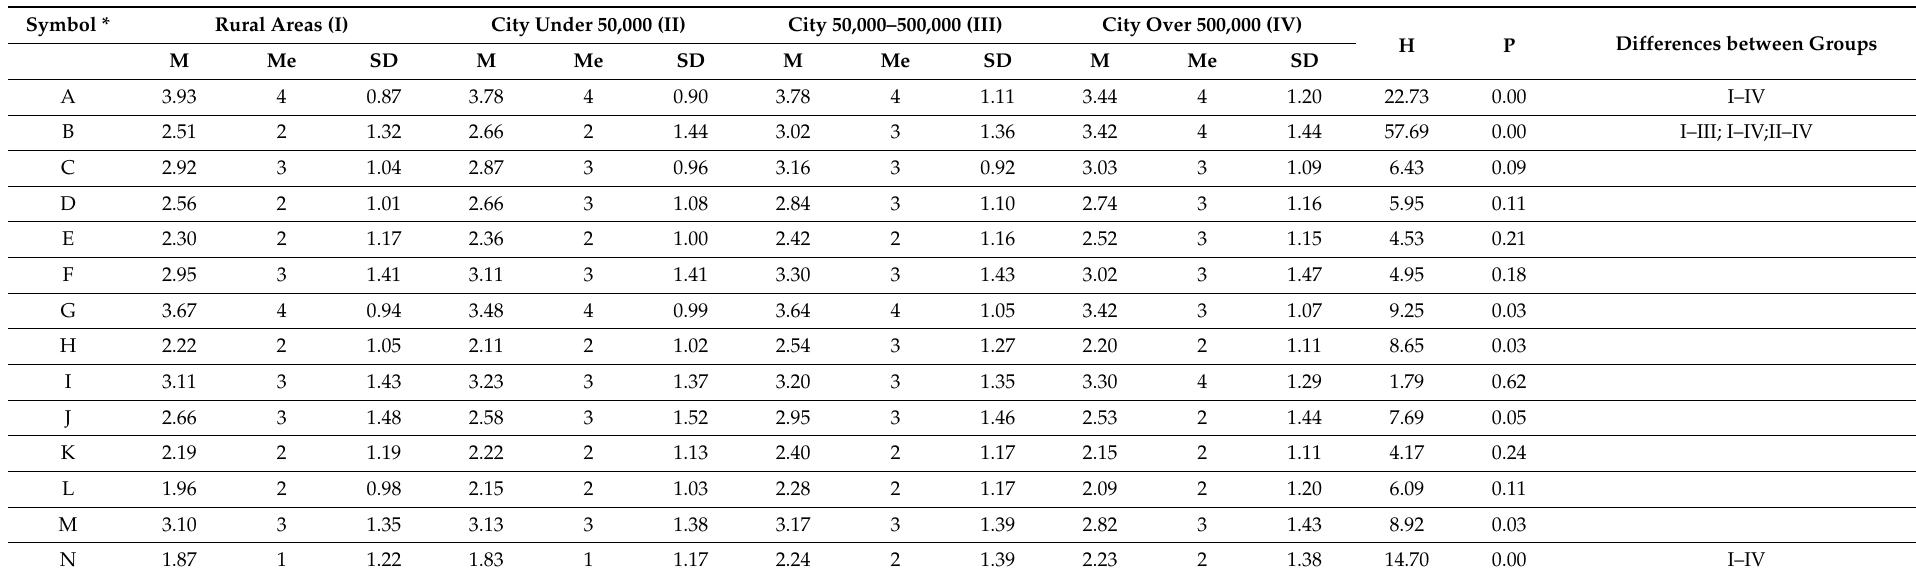
Table 4. Differences in the declaration of pro-environmental behaviors by the place of residence (Kruskal-Wallis test).